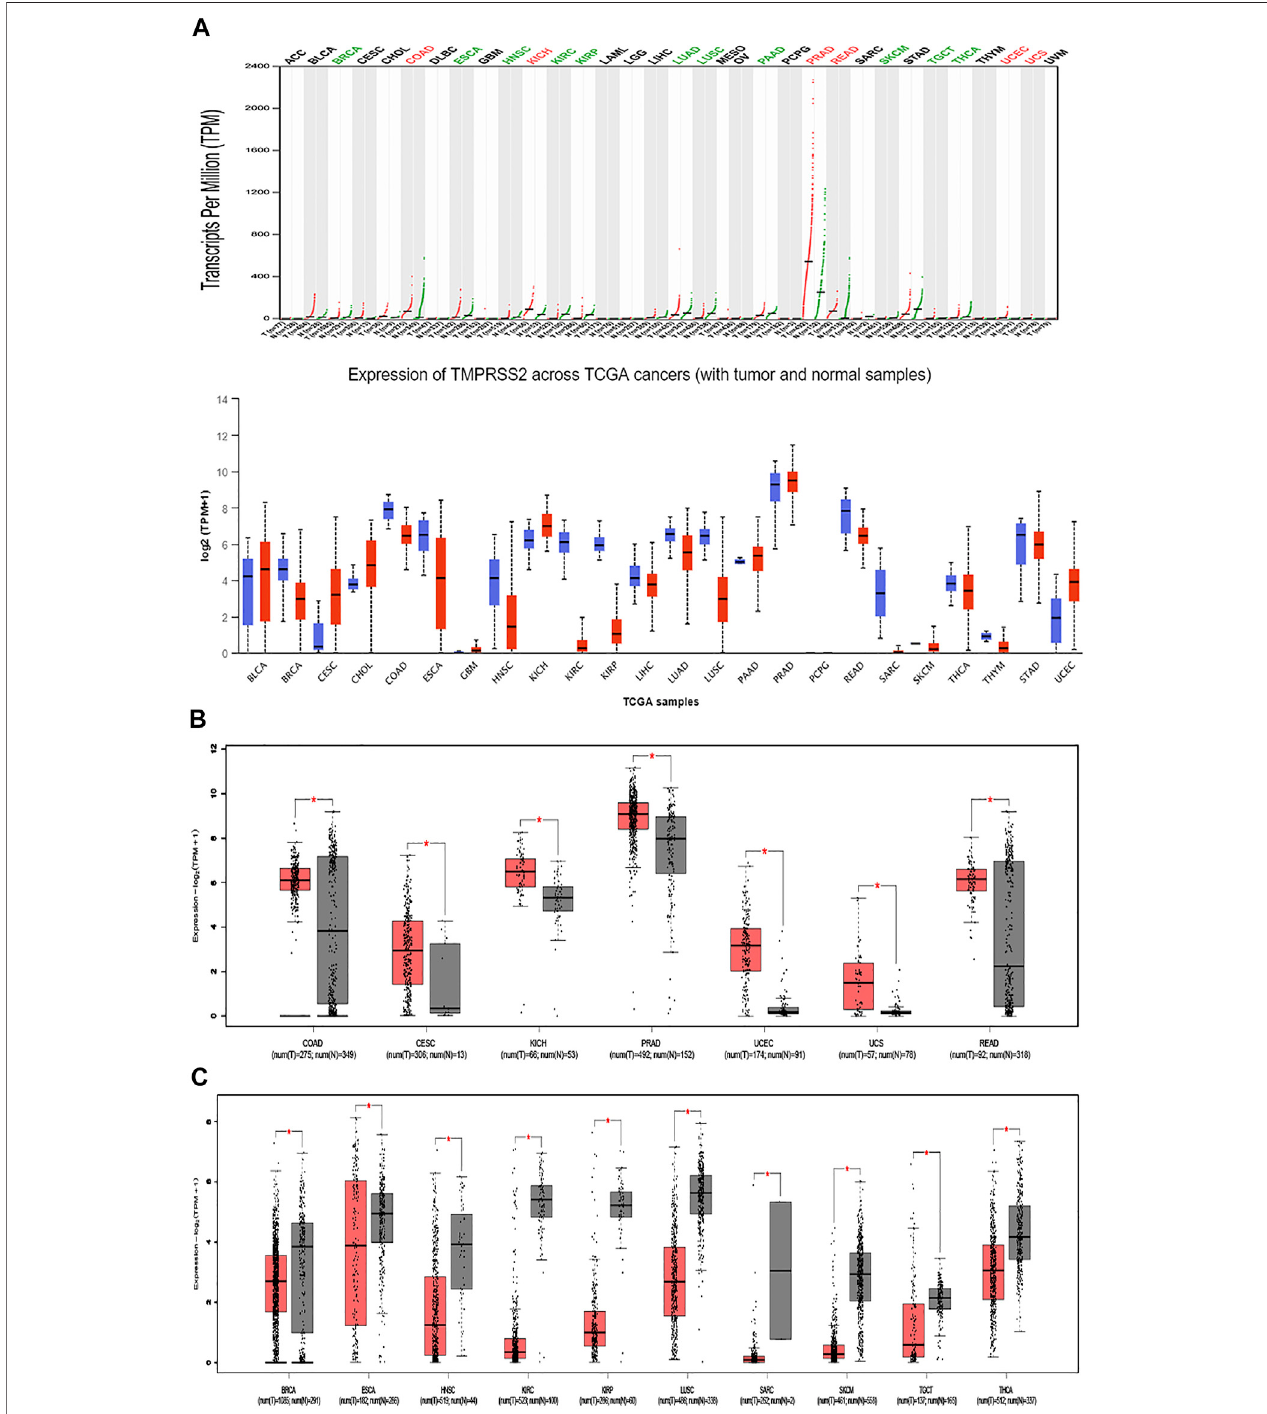
FIGURE 4 | Overall survival (OS) data for malignant tumors overexpressing TMPRSS2. (A) Survival picture of tumors overexpressing TMPRSS2; (B) OS in tumors overexpressing TMPRSS2.